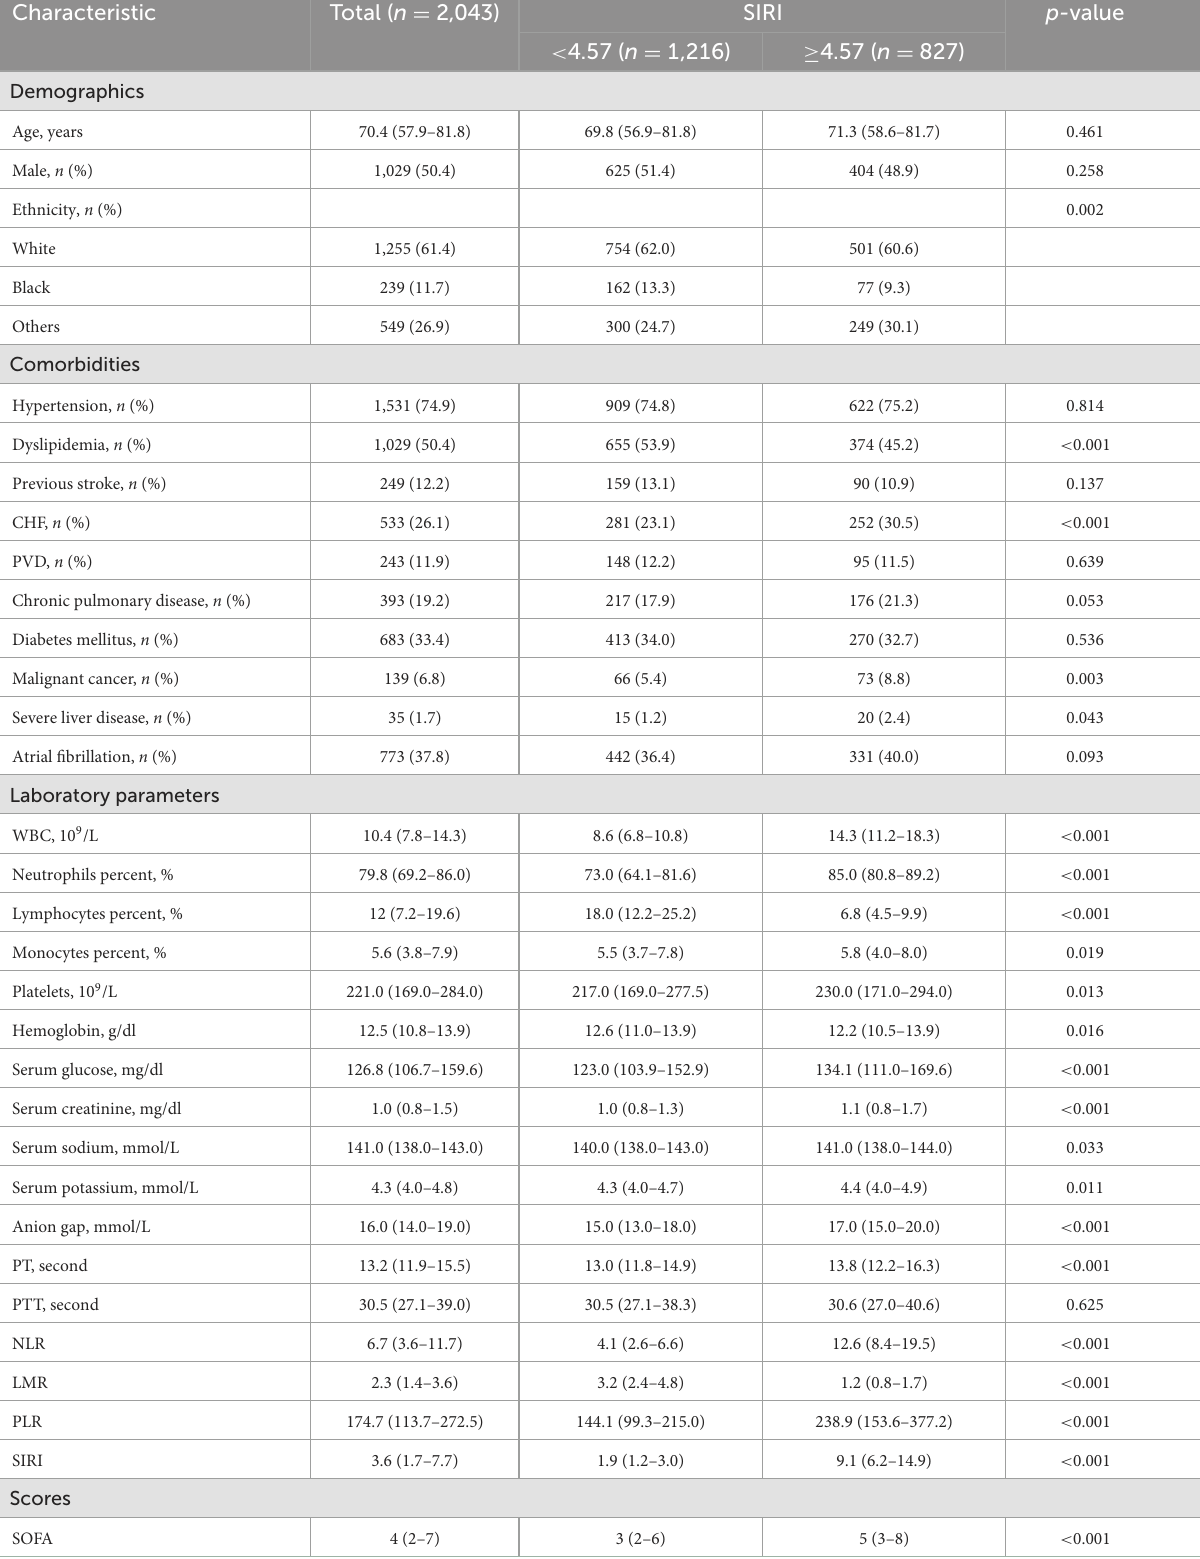
TABLE 1 Demographic and clinical characteristics before propensity score